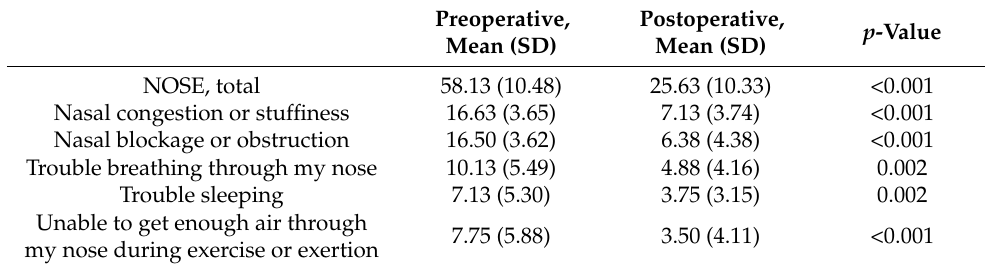
Symptom improvement assessed by the Nasal Obstruction Symptom Evaluation (NOSE)